Question: Write a single sentence explaining what this figure depicts.
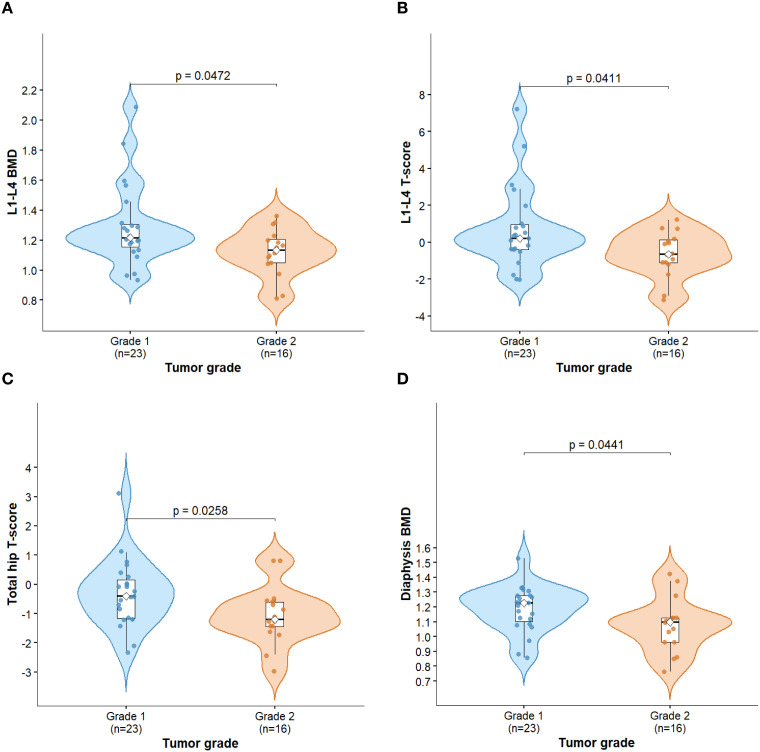
Answer: Violin plots showing the comparison according to tumor grade of (A) L1-L4 BMD (bone mineral density); (B) L1-L4 T-score; (C) total hip T-score and (D) diaphysis BMD. Statistical comparisons are reported with the corresponding p-values.